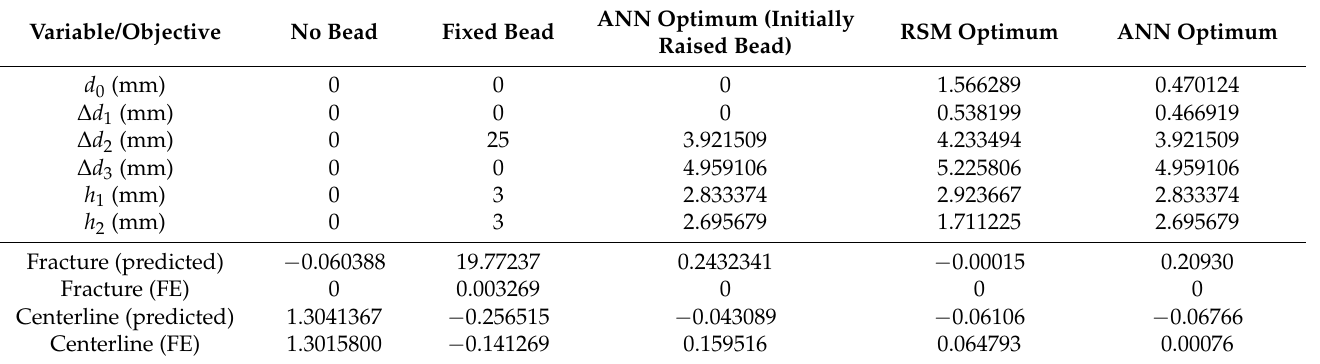
Table 5. Overall optimization